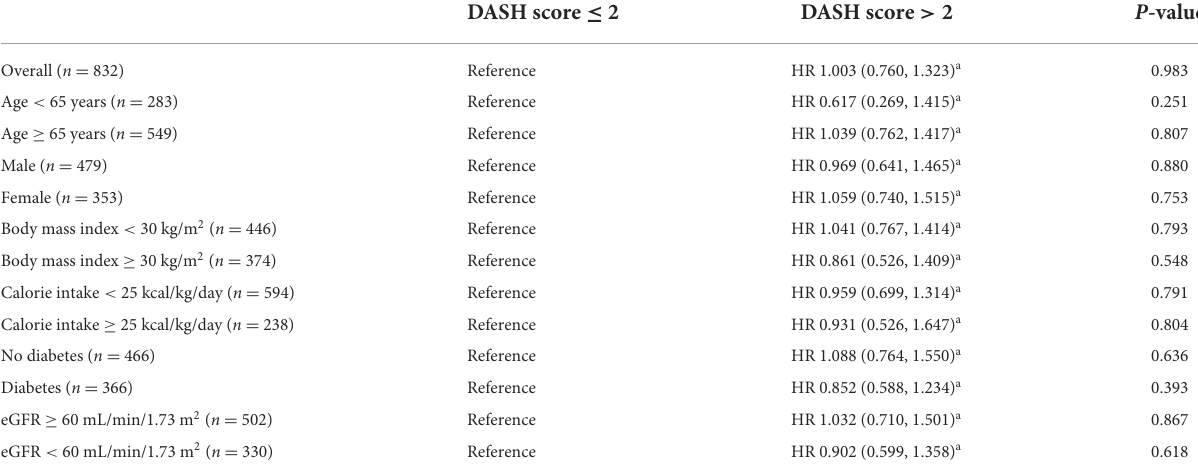
TABLE 3 Association of DASH score ( > 2 vs. ≤ 2) with all-cause mortality in various subgroups.